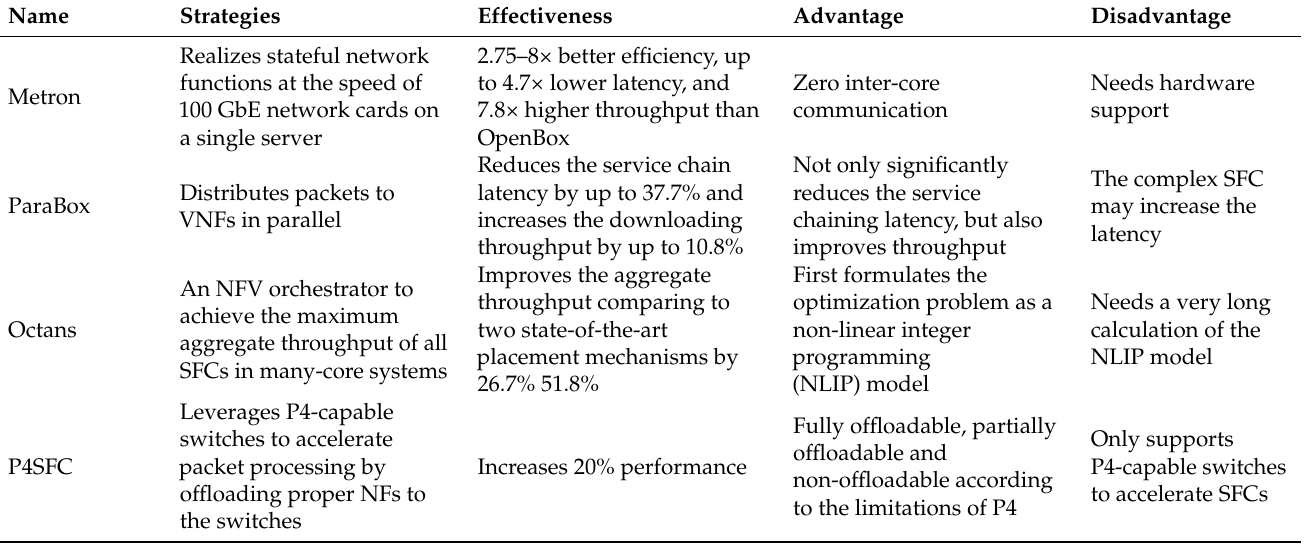
Table 6. The acceleration solutions in